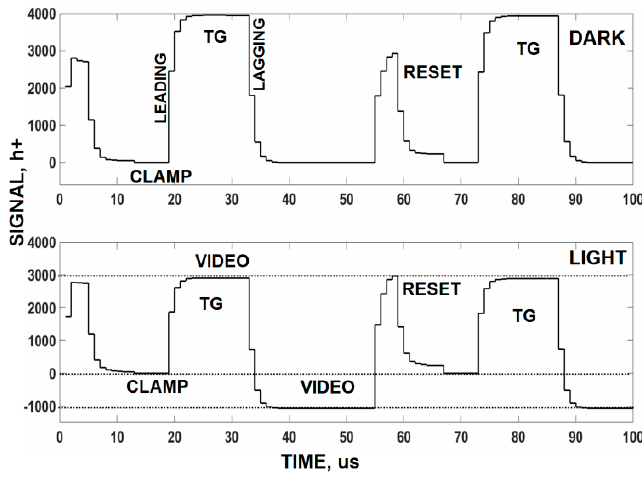
Figure 14. Dark ( top ) and light ( bottom ) raw video responses showing the pixel’s clock feedthroughs and the video level.